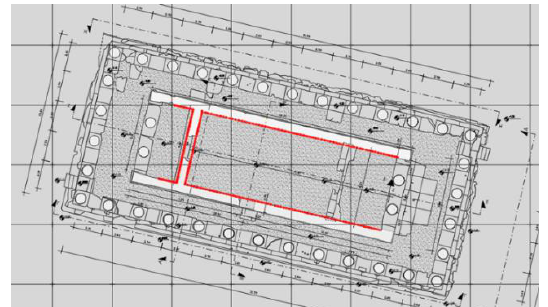
Figure 15. Depiction of the horizontal edges compared to the drawing of the horizontal section of the Temple The horizontal edges were extracted from suitable parts of the point cloud, i.e. part of the vertical walls approximately 30cm wide at a height of 1.30-1.60m and of the floor, approximately 50 cm wide. The mean differences of the edge pairs were in the order of 5mm (Figure